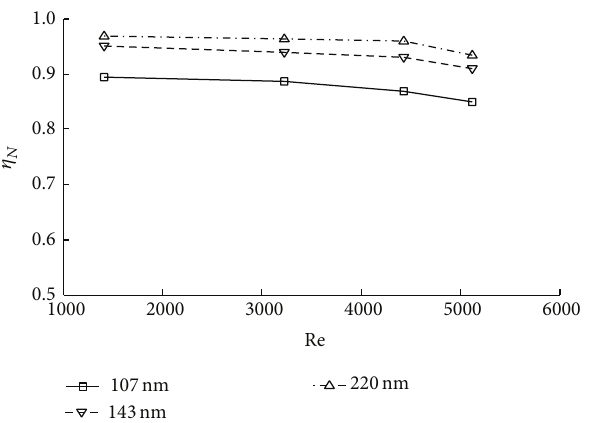
Figure 6: Penetration efficiencies for different